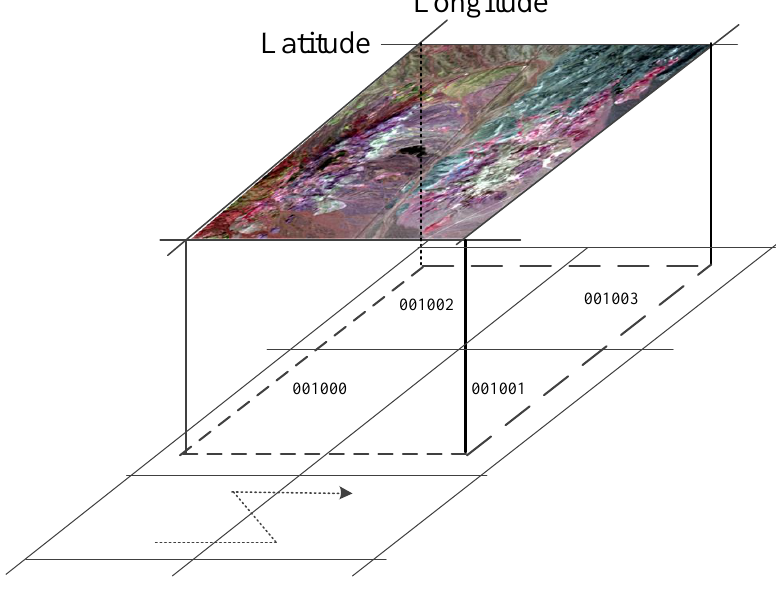
Figure 5. The virtual mapping between the logical partition indexing and the scene parameters of remote sensing